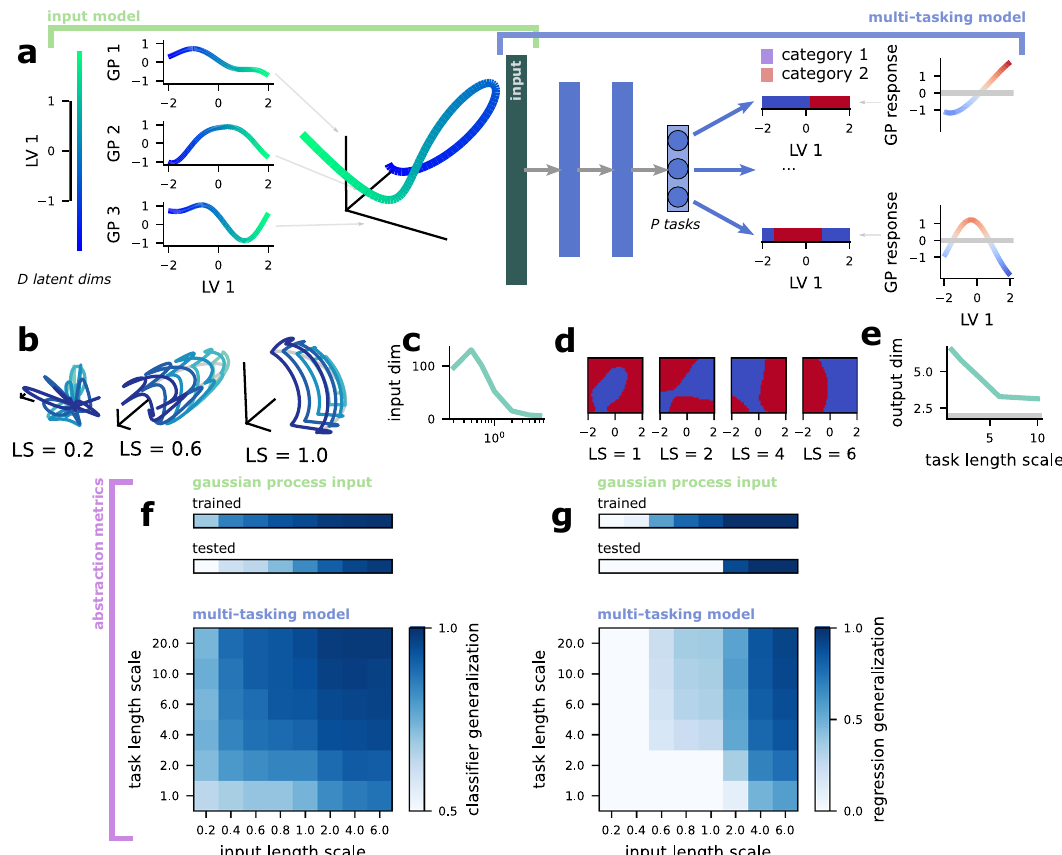
Fig. 5 | The multi-tasking model learns abstract structure from both random Gaussianprocess inputsand output tasks.a (left) Schematicof the creation of a random Gaussian process input for one latent variable dimension ( D =1). Random Gaussian processes with a length scale=1 are learned for the single latent variable shown on the left. Then, the responses produced by these random Gaussian pro- cesses are used as input to the multi-tasking model. The full random Gaussian process input has 500 random Gaussian process dimensions and D =5 latent vari- ables. (right) Schematic of the creation of two random Gaussian process tasks for the D =1-dimensionallatent variable shown on the left, showing both two example binary classi fi cation tasks and the random Gaussian process that is thresholded at zerotocreateeachtask. b VisualizationoftheinputstructureforrandomGaussian